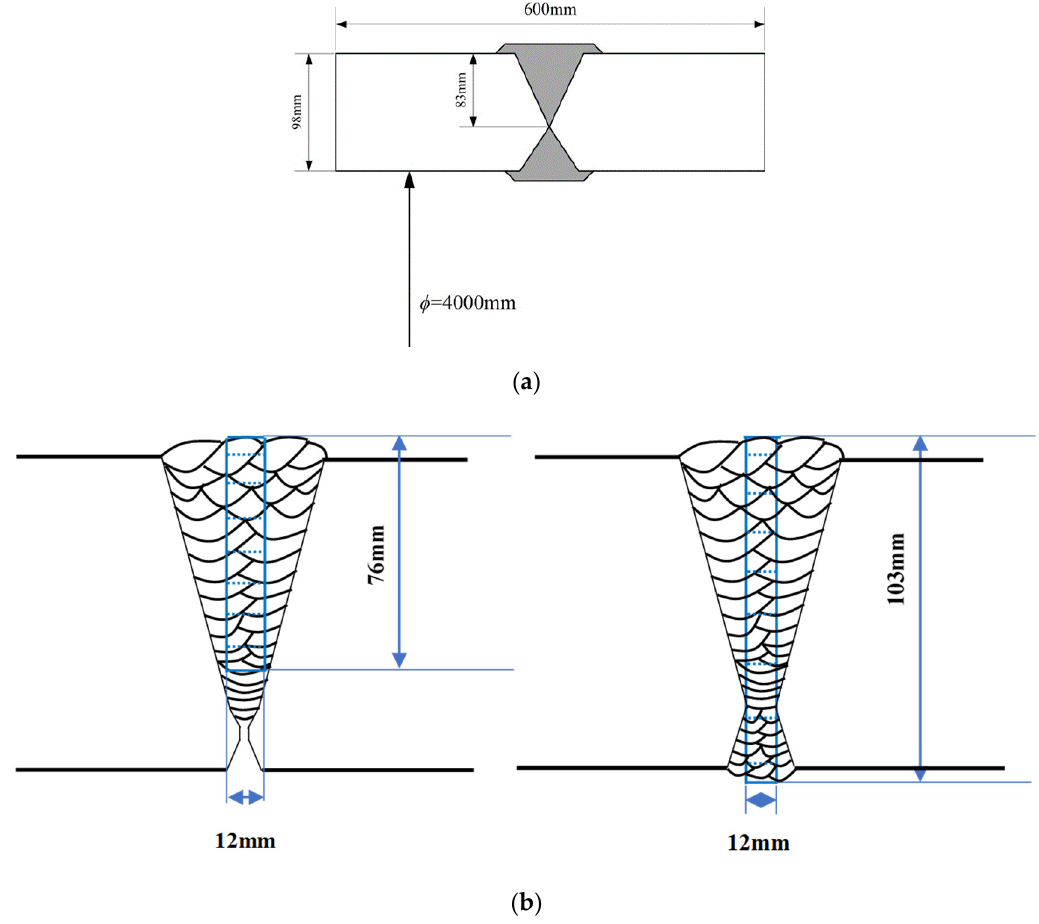
Figure 1. Welded joint size and detection position of residual hydrogen concentration of heavy plate welded joint: ( a ) Welded joint size; ( b ) detection position of residual hydrogen concentration [20].